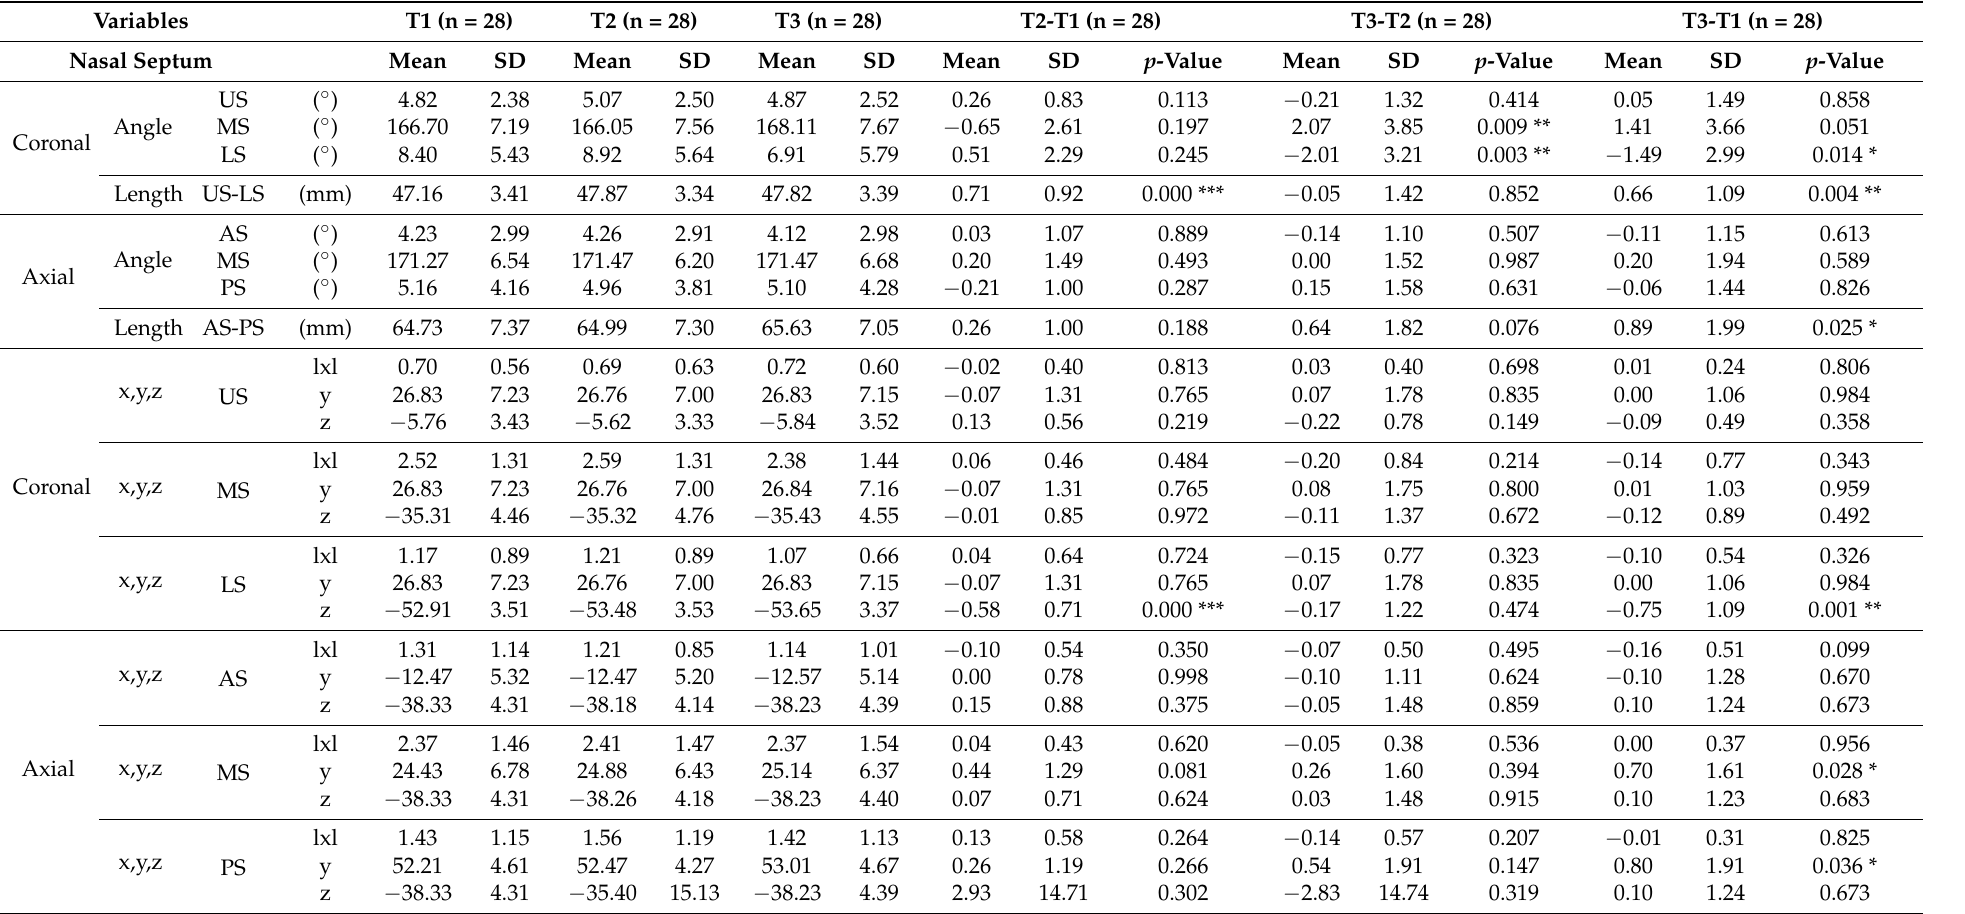
Table 3. Three-dimensional values and changes of nasal septum and nasofacial structures after